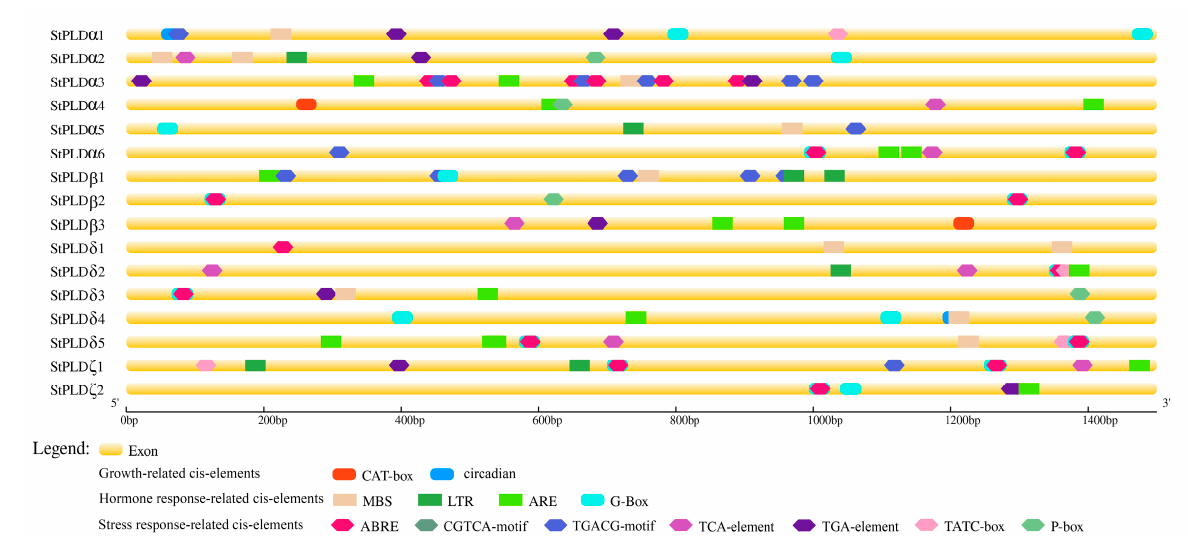
Figure 5. The cis-acting element of 1500 bp sequences upstream of the potato StPLD gene. This study used the database PlantCARE to predict the motif.